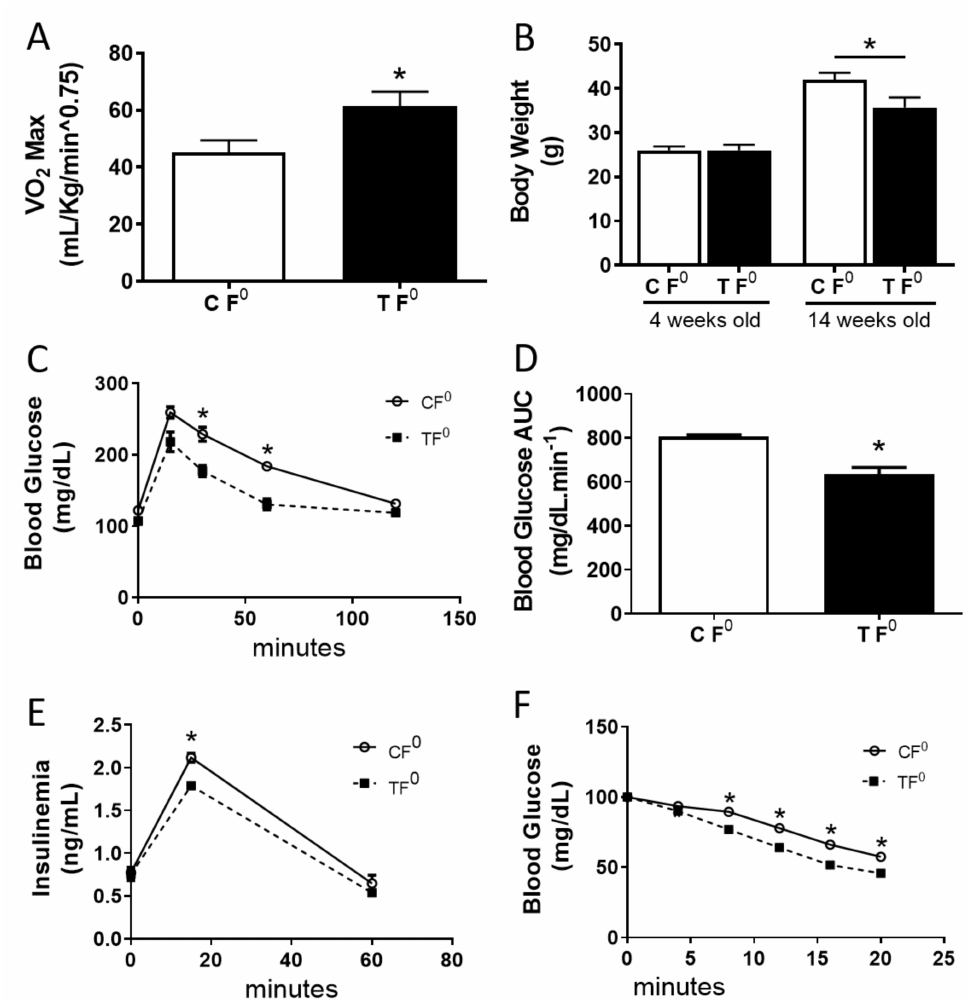
Figure 1. Controlled exercise regimen improves metabolic health in male mice . ( A ) Maximal oxygen consumption of sedentary male progenitor mice CF0 (white bar) and trained male progenitor TF0 (black bar) after the exercising training program. ( B ) Body weight of sedentary male progenitor mice CF0 (white bar) and trained male progenitor TF0 (black bar) before and after the exercise training program. ( C ) Glucose tolerance test, (1 g/Kg, b.w.) of sedentary male progenitor mice CF0 (solid line) and trained male progenitor TF0 (dashed line). ( D ) Area under the curve from glucose tolerance test of sedentary male progenitor mice CF0 (white bar) and trained male progenitor TF0 (black bar). ( E ) Plasma insulin levels during the glucose tolerance test of sedentary male progenitor mice CF0 (solid line) and trained male progenitor TF0 (dashed line). ( F ) Insulin tolerance test (1 U/Kg/b.w.) of sedentary male progenitor mice CF0 (solid line) and trained male progenitor TF0 (dashed line). Data are presented as the mean ± SEM. * p ≤ 0.05 vs. CF0 using two-tailed t -test. n =